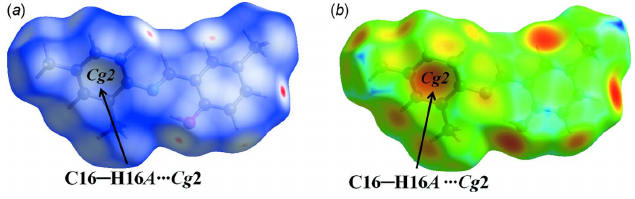
Figure 3 The red spots on the d norm and d e surfaces of the title molecule represent the C—H (cid:2)(cid:2)(cid:2) (cid:2) interactions.